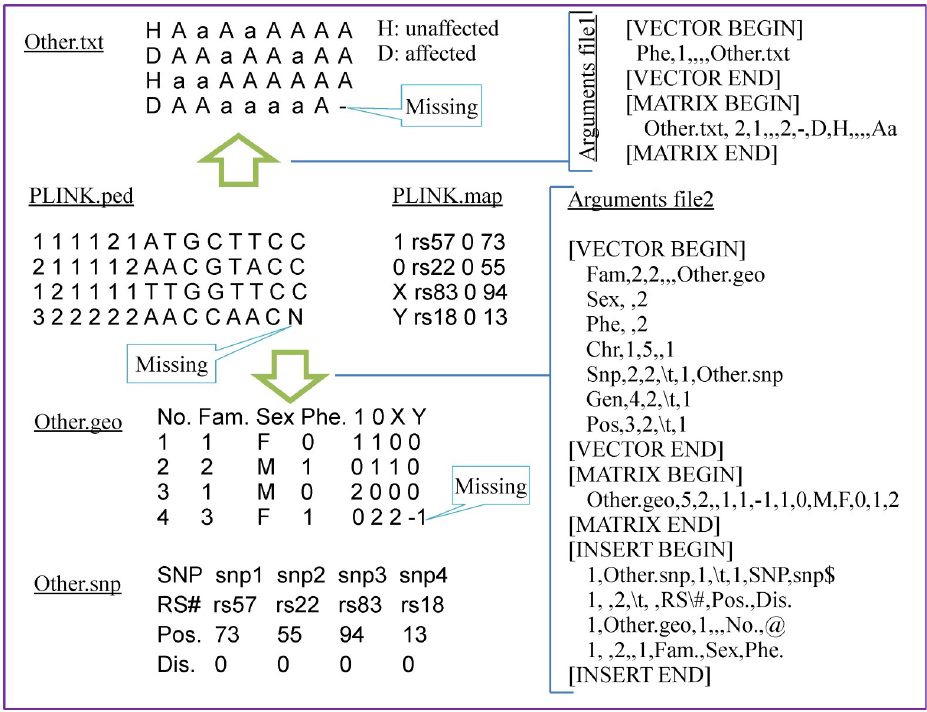
Fig 1. Example of converting PLINK PED to user-defined format. The files Other.geo and Other.txt are space delimited (more spaces were added for readability), and the Other.snp is tab delimited. The delimiter in the arguments files is a comma which can be ignored if there are no more items such as “Sex, 2” in Arguments file 2. The MATRIX section describes the components of the genotype matrix while the VECTOR section gives the other components of the data, and the INSERT section provides how to insert additional